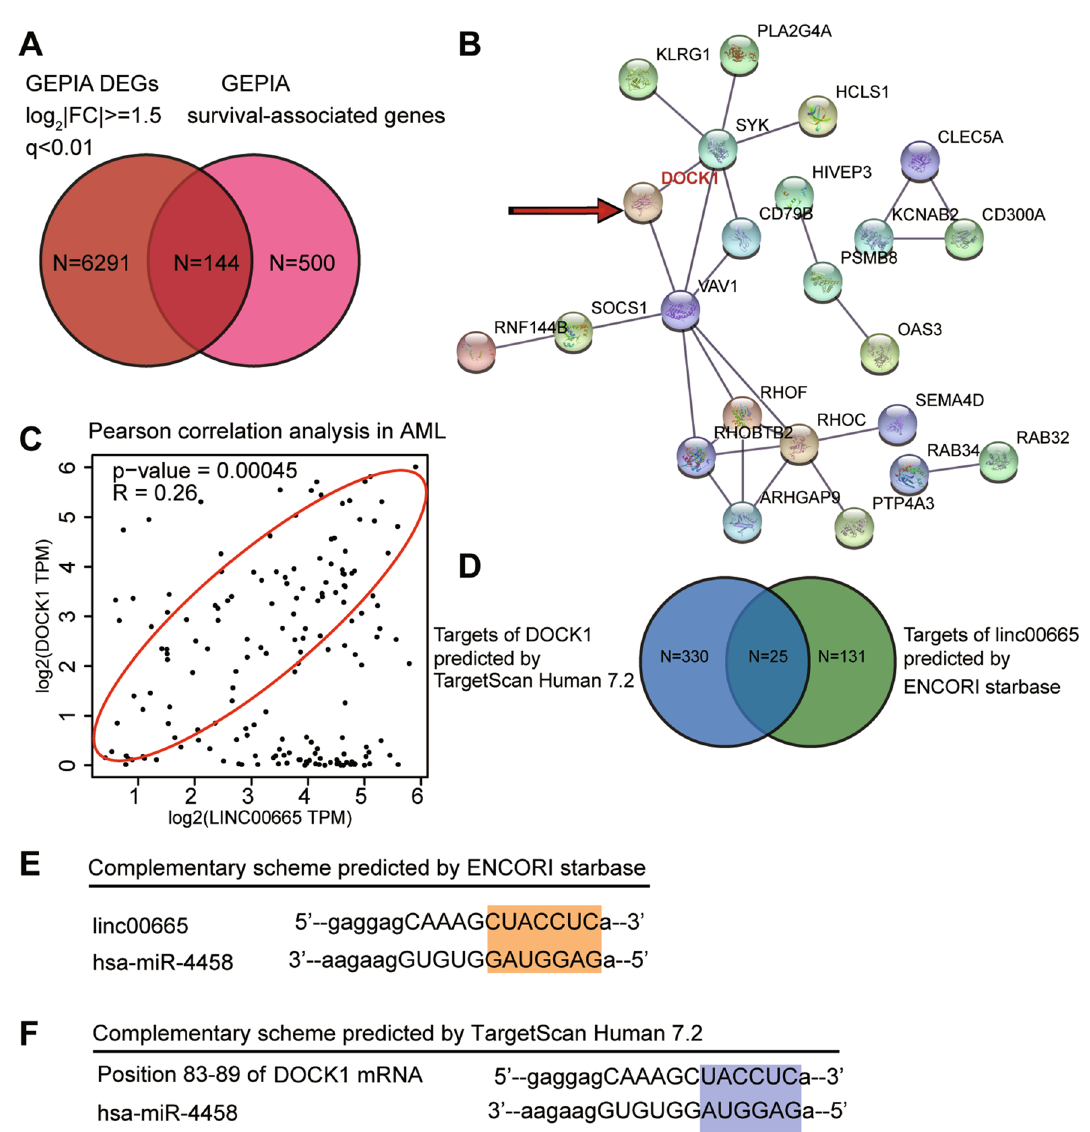
Figure 1. DOCK1 and miR-4458 are the key regulators in AML. ( A ) Venny 2.1.0 overlapped 144 genes from GEPIA DEGs and GEPIA survival-associated genes. ( B ) DOCK1 was identifed as the key gene by STRING analysis. ( C ) The correlation between LINC00665 and DOCK1 was analyzed using GEPIA algorithm. ( D ) 25 miRNAs bridging between LINC00665 and DOCK1 mRNA were overlapped using Venny 2.1.0. ( E ) ENCORI starBase predicted the binding site between LINC00665 and miR-4458. ( F ) TargetScan predicted the binding site between DOCK1 and miR-4458.